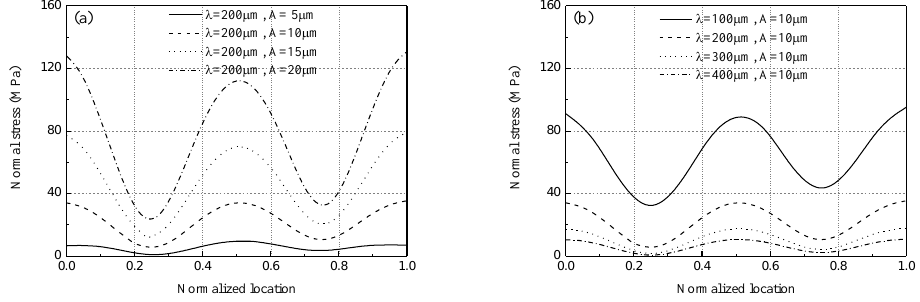
Figure 6. Variations of normal thermal residual stress along the EBC/BC interface of CMCs coatings with different ( a ) amplitude; ( b ) wavelength.